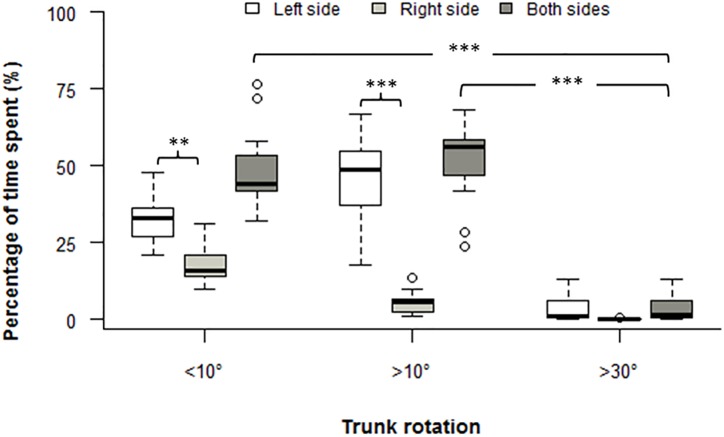
Pruning boxplot of the percentage of time spent at each cut-off angles for trunk rotation *: P < 0.05; **: P < 0.01; ***: P < 0.001.